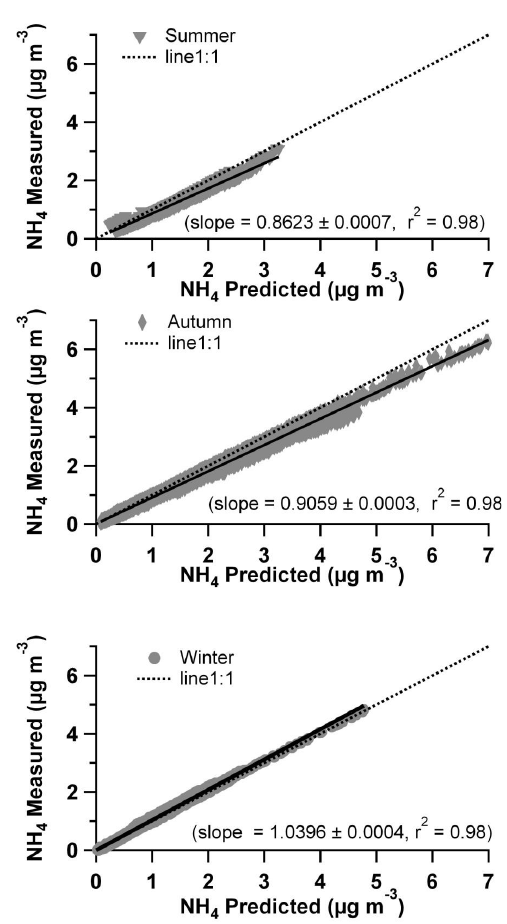
Figure 1. Comparison of the measured ammonium with the predicted ammonium concentration assuming a fully neutralization by nitrate, sulfate and chloride for the three different campaigns.